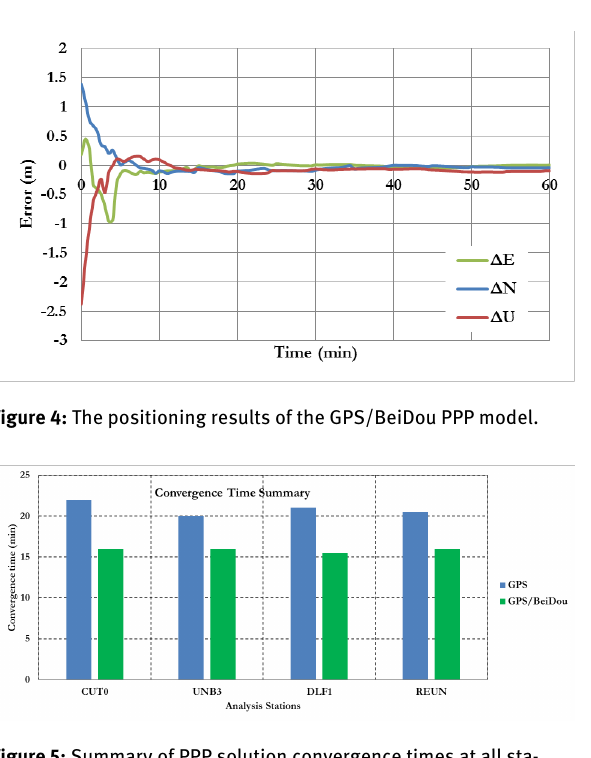
Figure 5: Summary of PPP solution convergence times at all sta- tions.